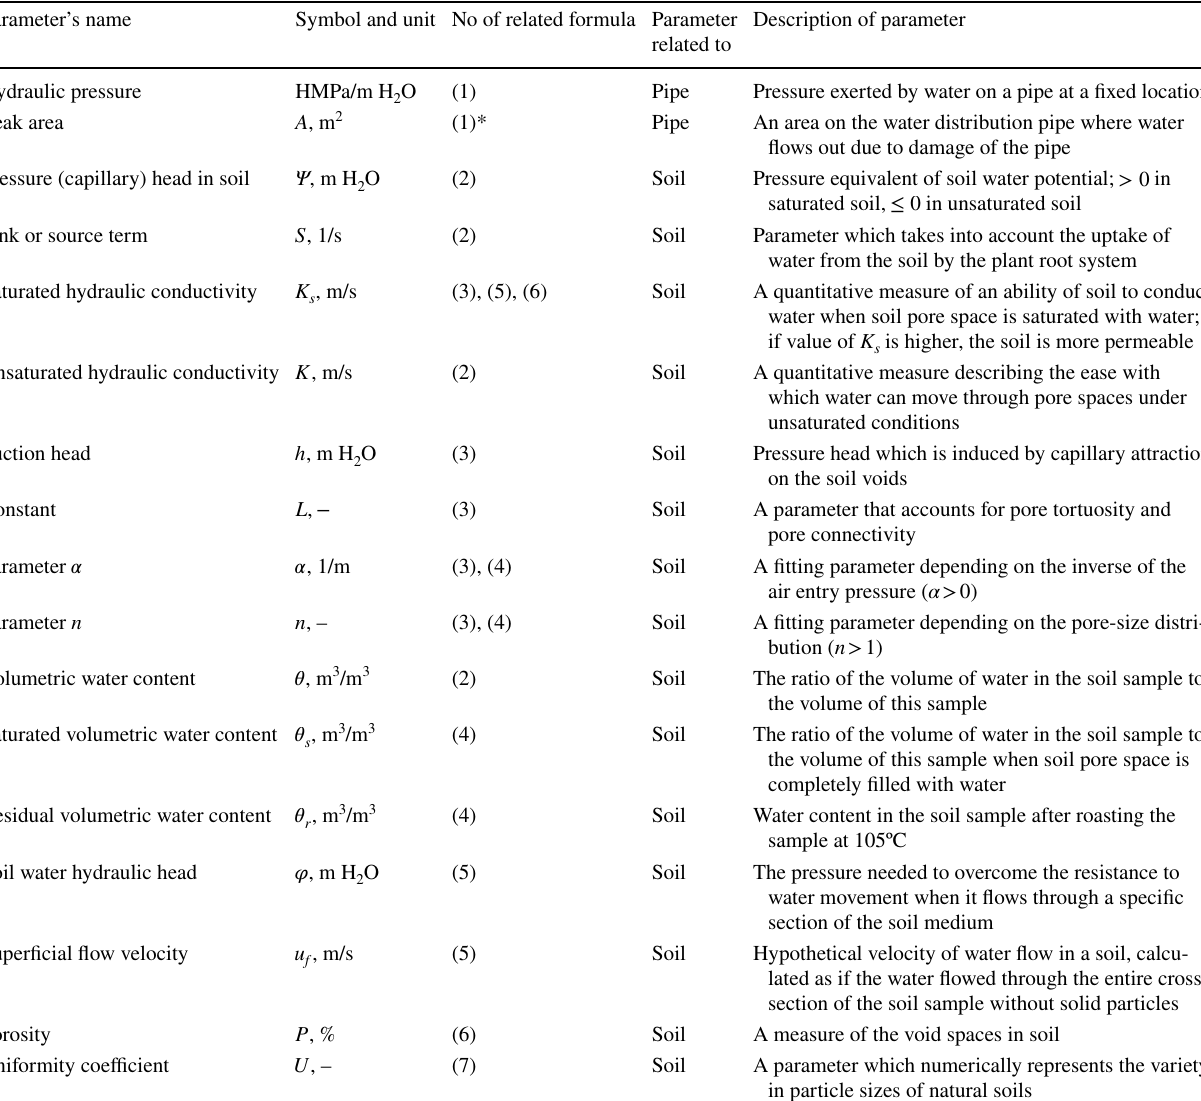
Table 1 Description of the parameters creating the set Z (9)